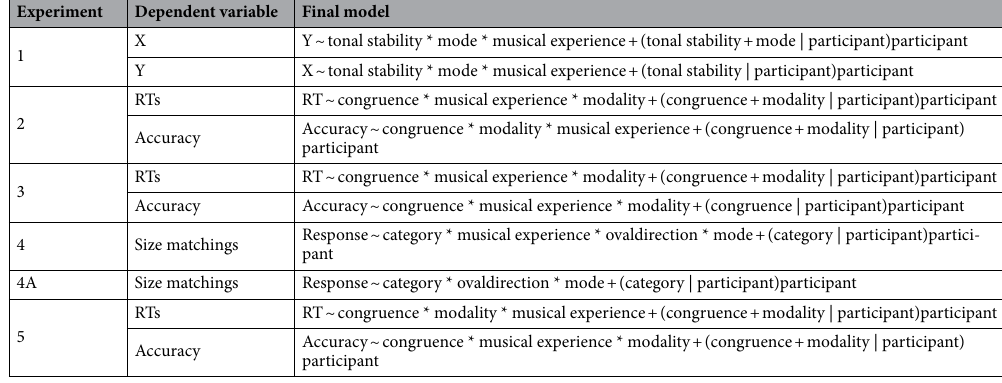
Table 4. List of the final mixed linear models in Experiments